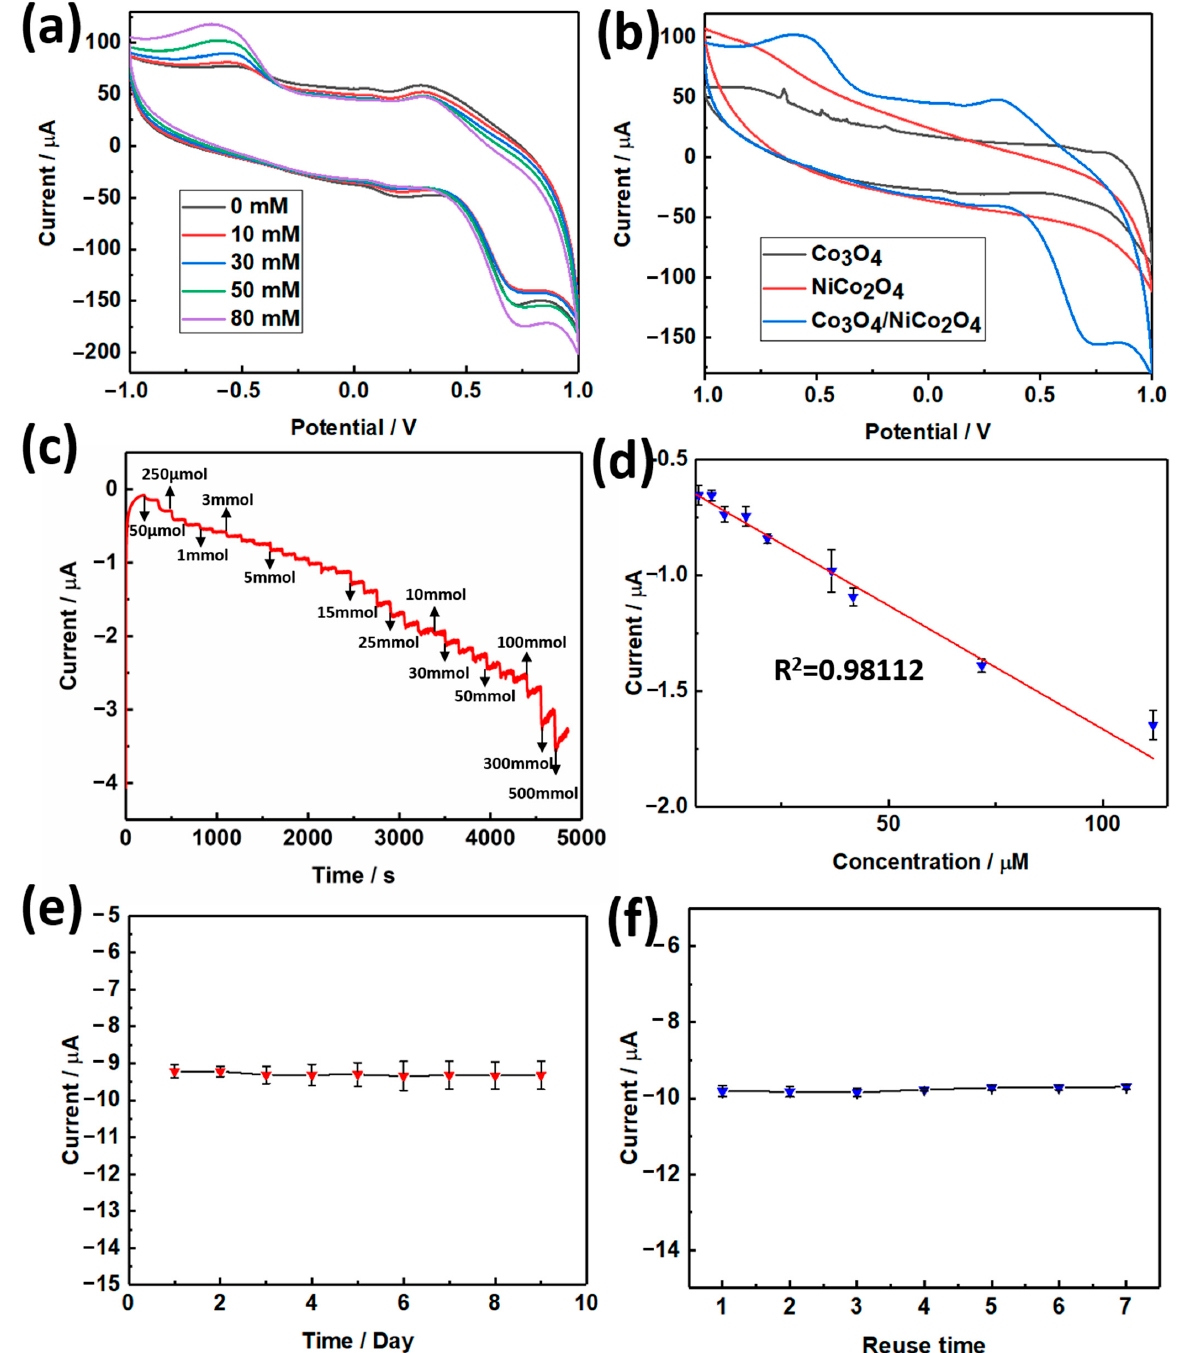
Figure 4. ( a ) The CV of Co 3 O 4 /NiCo 2 O 4 at 50 mV/s, adding H 2 O 2 in different concentrations. ( b ) The CV of Co 3 O 4 , NiCo 2 O 4 , and Co 3 O 4 /NiCo 2 O 4 , with a scanning rate of 50 mV/s. ( c ) The I-t curve of Co 3 O 4 /NiCo 2 O 4 when H 2 O 2 was added in different concentrations every 150 s. ( d ) The linear regression curve, drawn according to Figure 4c. ( e ) The long time service life test of the H 2 O 2 electrochemical biosensor. ( f ) The reuse time test of the H 2 O 2 electrochemical biosensor.